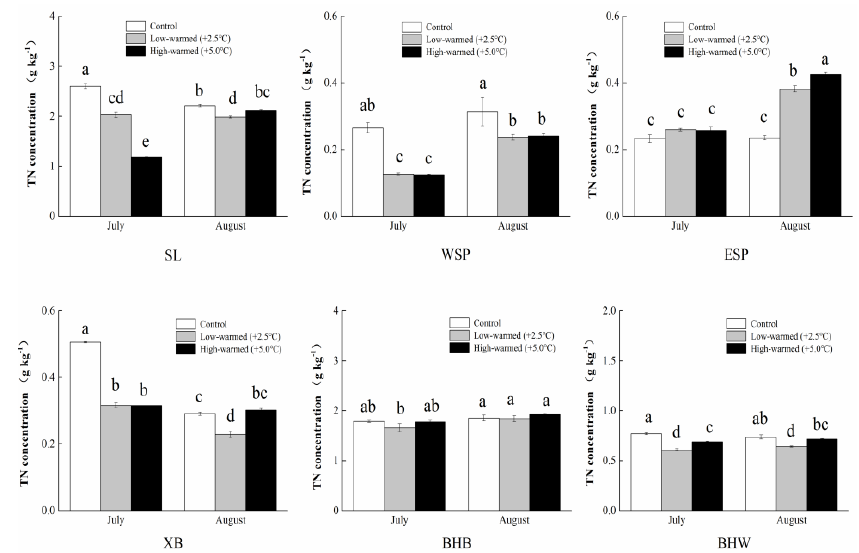
Figure 4. Statistical differences of total nitrogen (TN) in sediments collected from wetland pillars in the temperature simulation experiment (control: ambient temperature; low-warmed: ambient temperature +2.5 °C; high-warmed: ambient temperature +5.0 °C). The abbreviation of wetland sampling sites is identified on the x -axis, and the TN concentration in the sediments is identified on the y -axis. Error bars represent the standard error of the mean of three parallel samples. Values within the same sampling site follow by the same small letters (a, b, c, d, e) are not significantly different at p = 0.05.